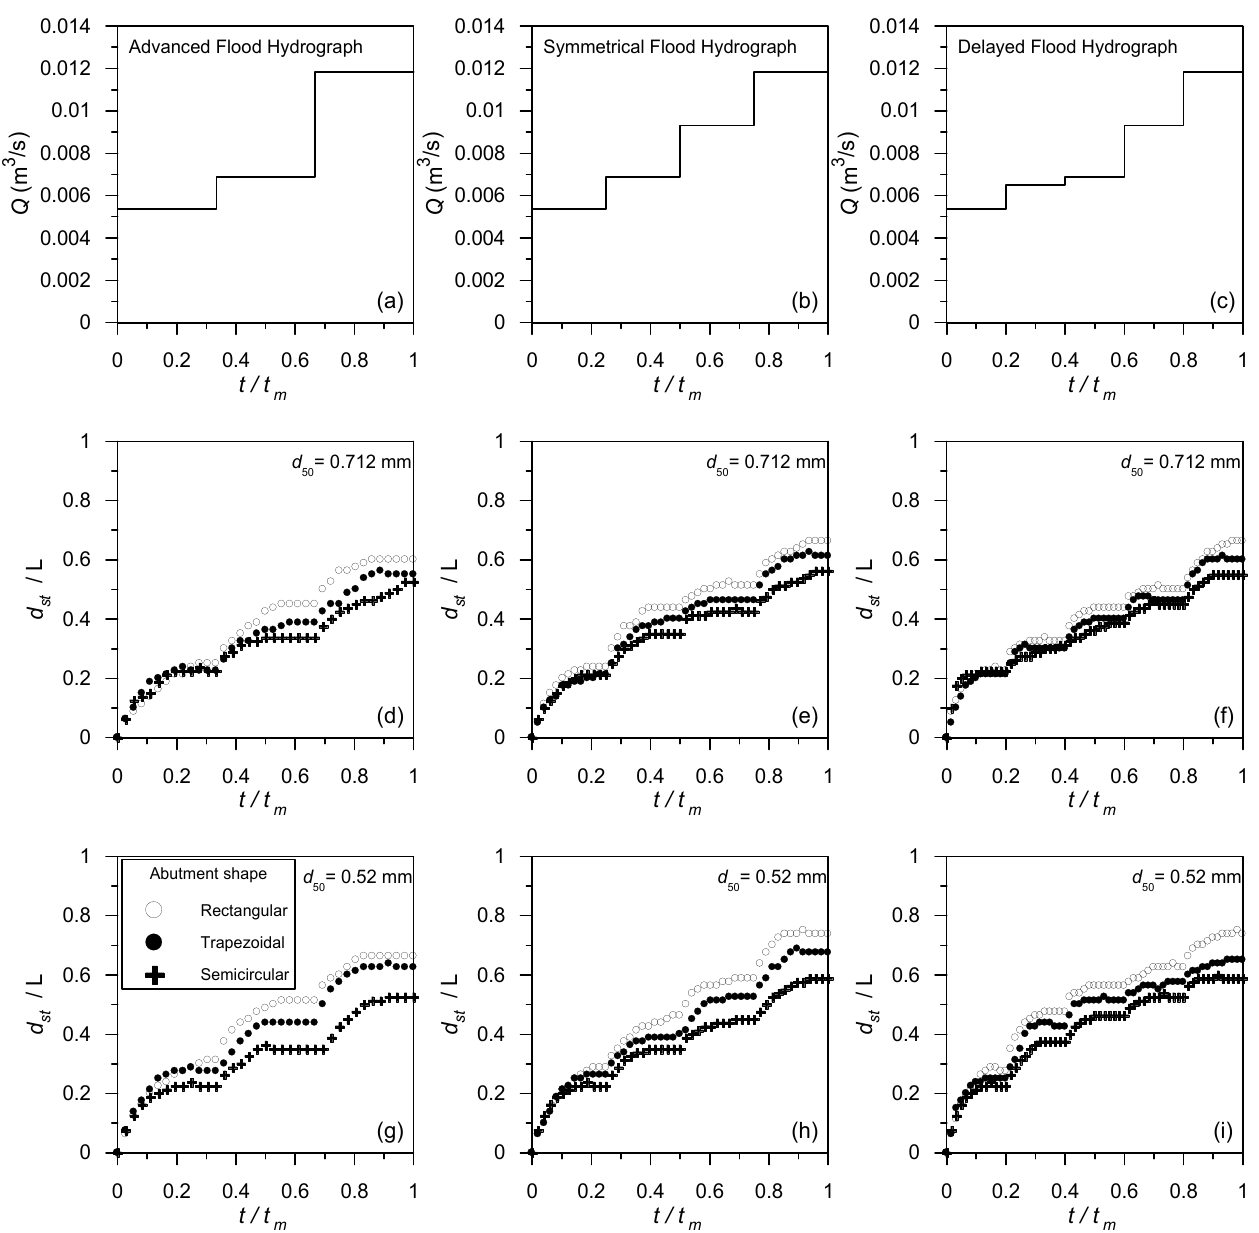
Figure 4. Comparison of temporal variation of non-dimensional scour depth d st / L for different abutment shapes and hydrographs.